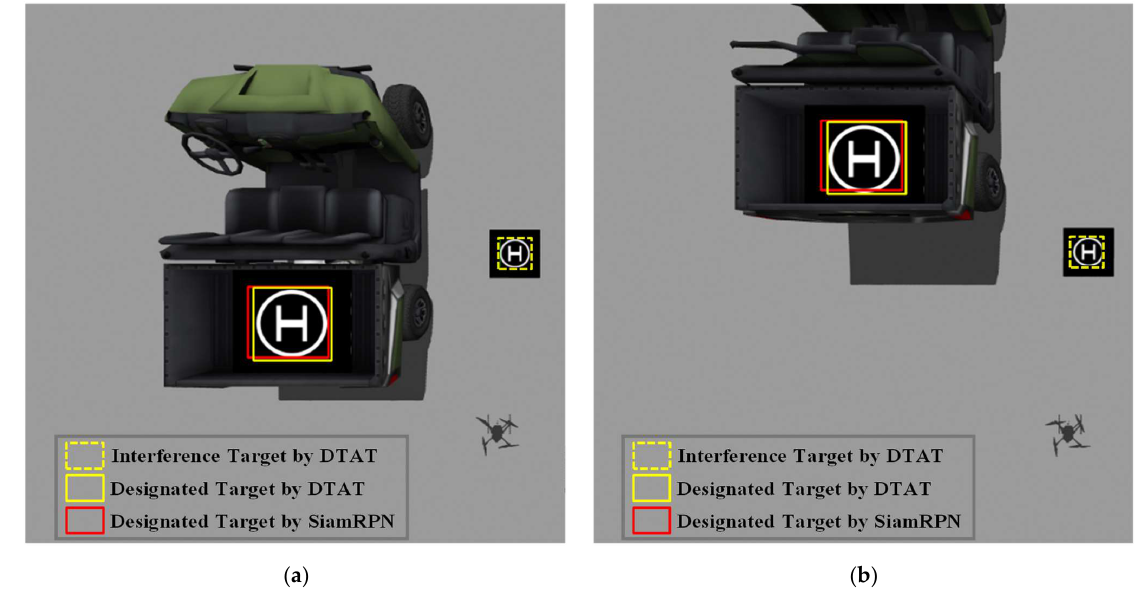
Figure 10. Multi-frame target tracking result. ( a ) Frame 20. ( b ) Frame 167.